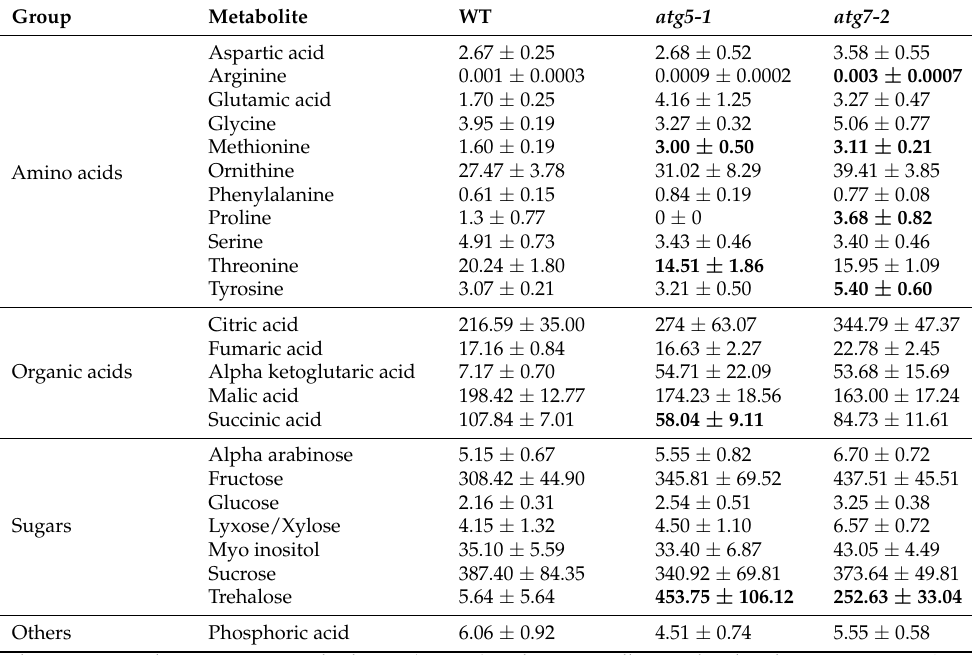
Table 1. Metabolic profiling of 10-day-old seedling roots under 3%